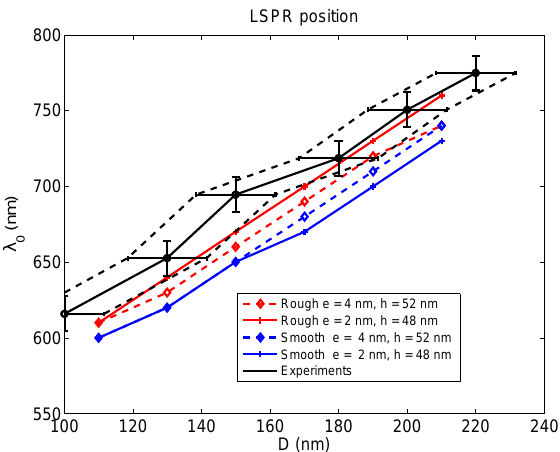
Figure 5: Experimental data from [26] with standard uncer- tainties. Intervals for the position of the LSPR computed with DDA, using experimental uncertainties, for smooth and rough